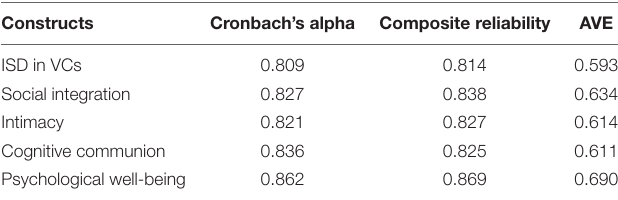
TABLE 2 | Composite reliability and average variance extracted (AVE).